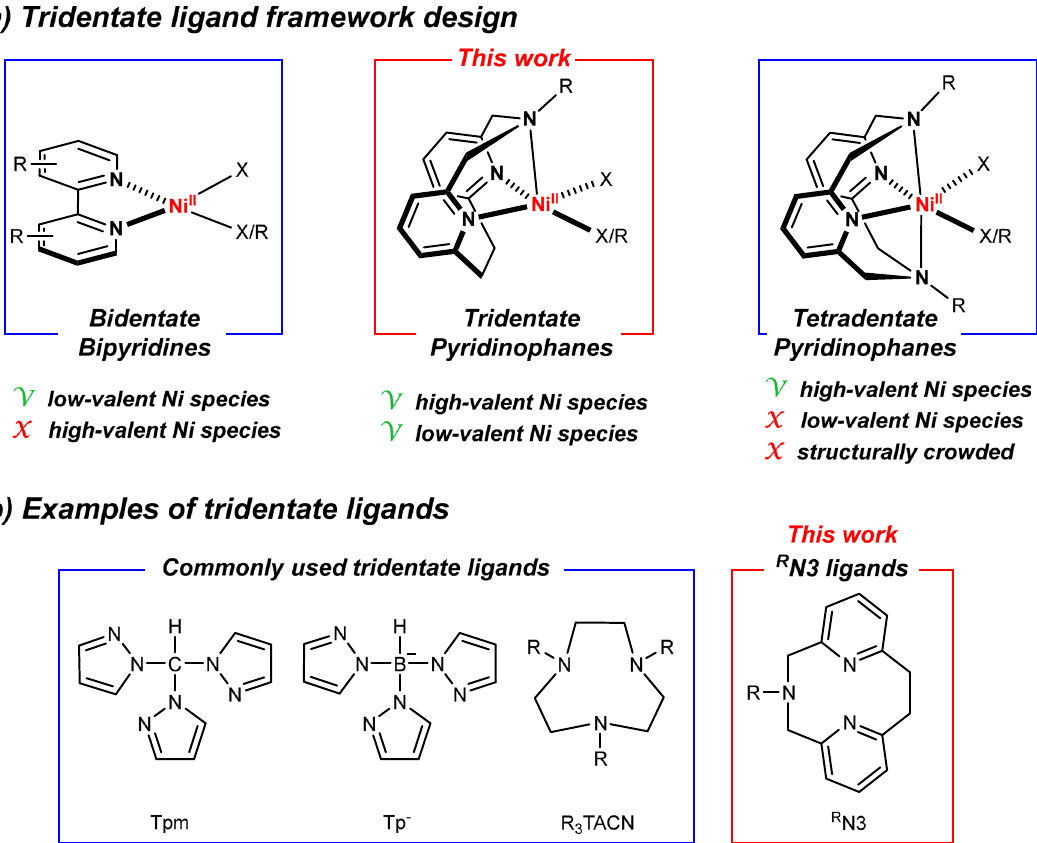
Fig. 1 Comparison of different N-donor ligands. a Tridentate ligand framework design. b Representative tridentate N-donor ligands commonly used for stabilizing uncommon Ni oxidation states and the R N3 tridentate ligands developed in this work.